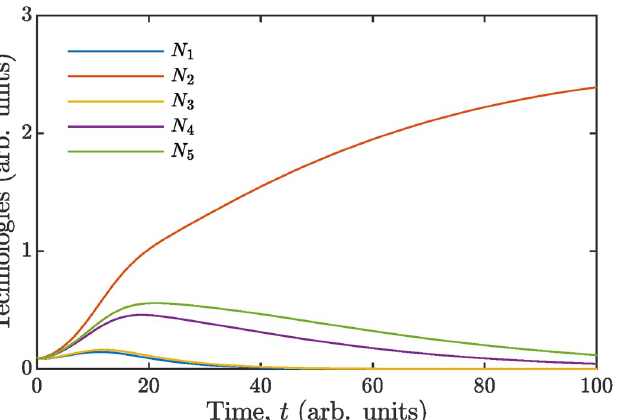
¼ 0 : 75 happens to be ð 2 Þ